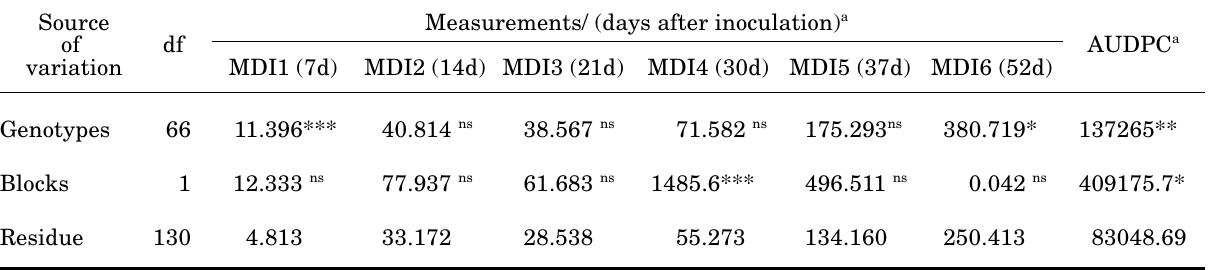
Table 1. Analysis of variance of the area under disease progress curve (AUDPC) and of the mass disease index (MDI) on leaves 7 to 52 days after inoculation with Botrytis fabae under field